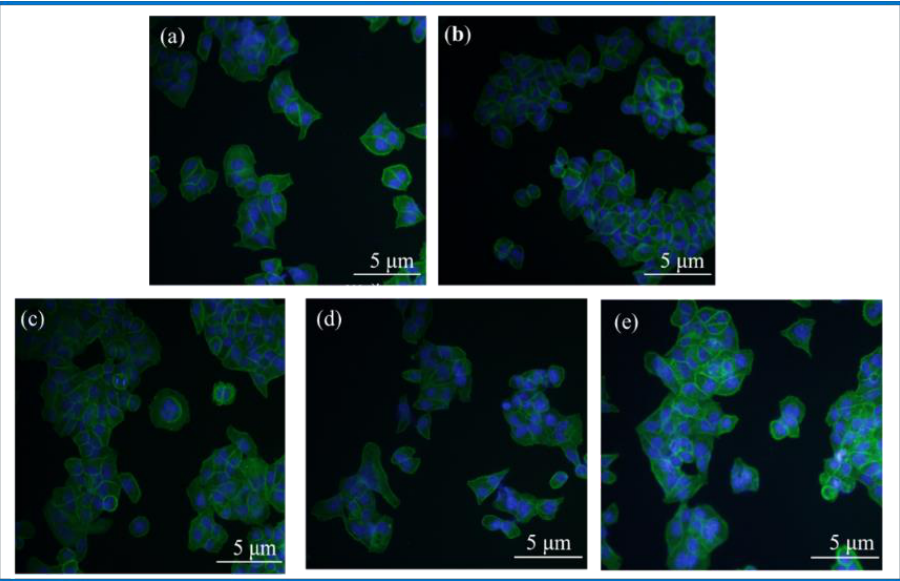
Figure 12. Photographs of fluorescence staining of cell immunology after 24 h co-culture with materials. ( a ): Blank group; ( b ): BC membrane; ( c ): PLA/BC-1; ( d ): PLA/BC-2; ( e ): PLA/BC-3.